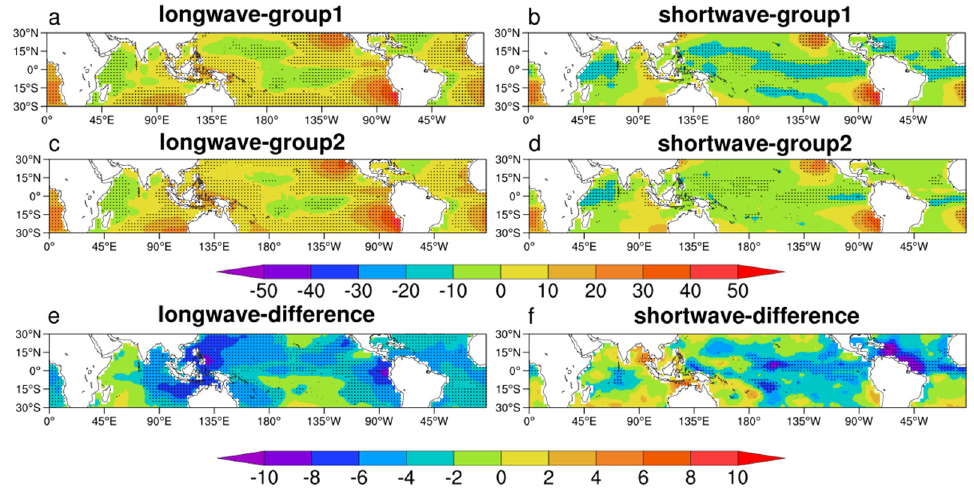
Figure 13. (left) Bias in Q LW of ( a ) group 1 models (<1.5 ° resolution) , ( c ) group 2 models (>1.5 ° resolution) , and ( e ) their differences. Right panels ( b, d, f ) are for Q SW. Dotted areas at the bottom panels indicate where the difference is statistically significant at the 95% level. Unit: W m −